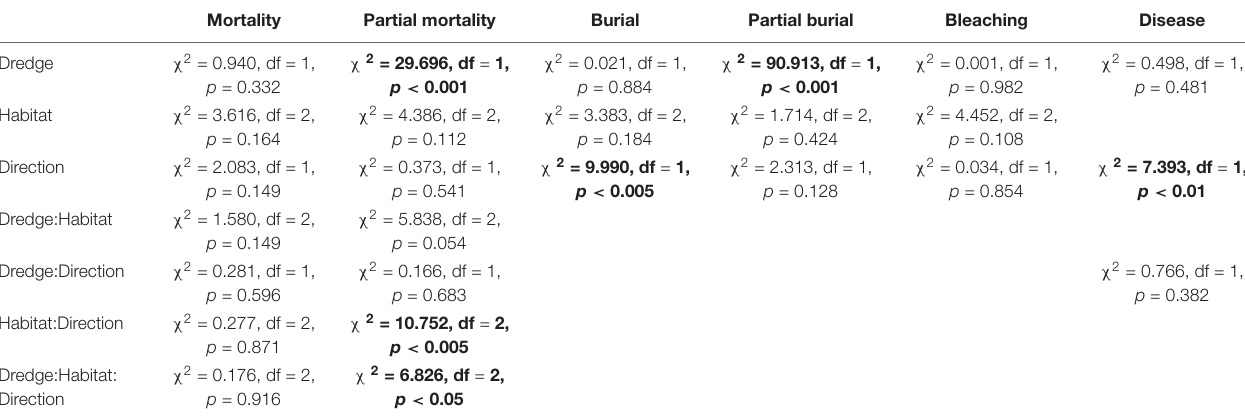
TABLE 1 | Summary of the Type 2 ANOVA results [chi-square( χ 2 ), degree of freedom (df), and p -value ( p )] from the negative binomial generalized linear mixed effect models for each of the six coral conditions (mortality, partial mortality, burial, partial burial, bleaching, and disease). Mortality Partial mortality Burial Partial burial Bleaching